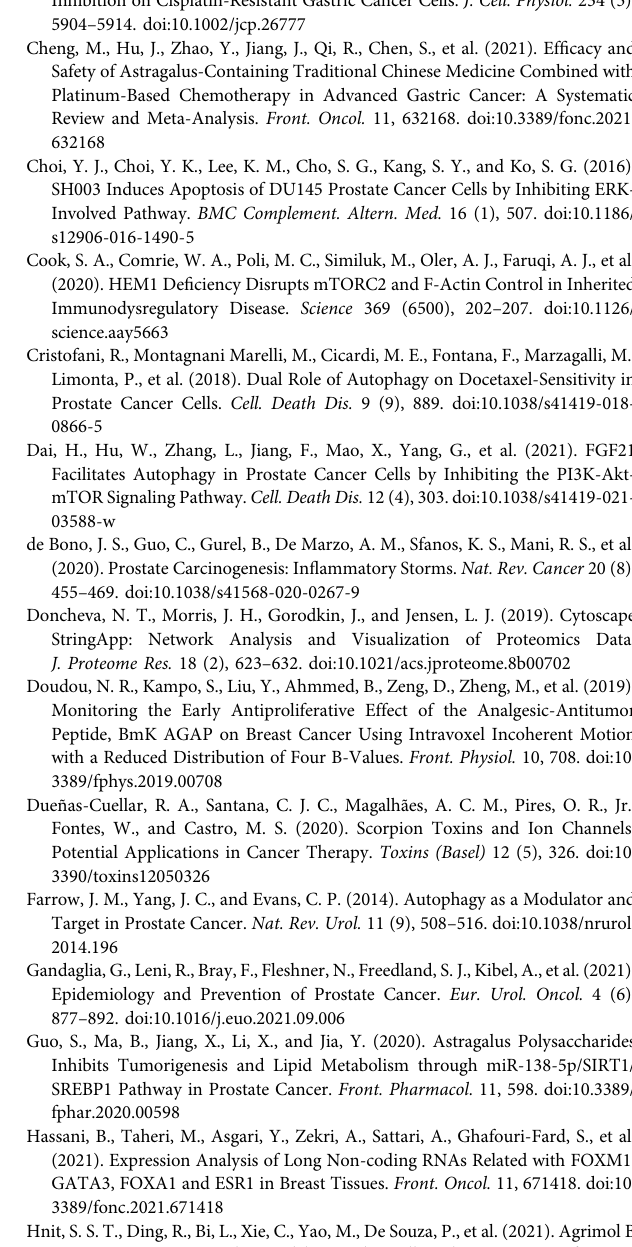
Supplementary Figure S1 | The chemical structures of various screened active ingredient monomers in the A – S drug pair. (A) The chemical structure of the active ingredient monomers in the Astragalus. (B) The chemical structure of the active ingredient monomers in the